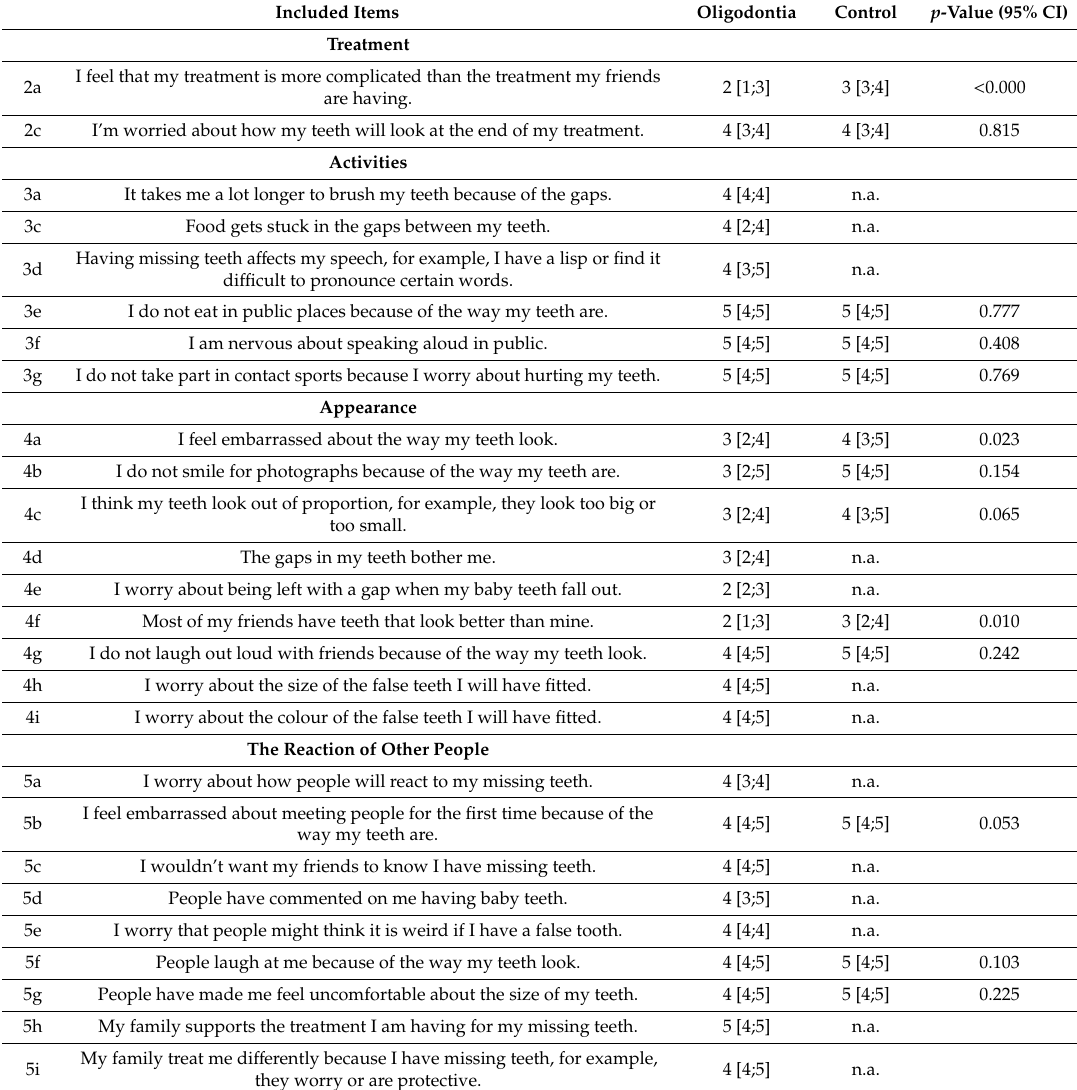
Table 2. Included item-scores (median, IQR) of the oligodontia and control patients. All questionnaires were completed prior to the onset of orthodontic treatment. CI = confidence interval; n.a. = not